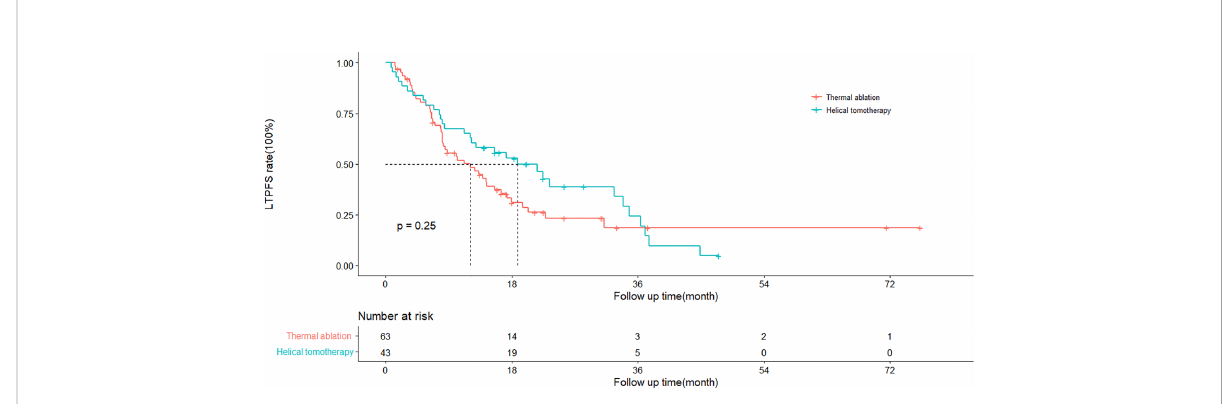
FIGURE 2 Kaplan – Meier curves of local tumor progression-free survival (LTPFS) in patients with pulmonary metastases from hepatocellular carcinoma who underwent thermal ablation or helical tomotherapy (thermal ablation group: n = 63, median LTPFS = 22.5 months; helical tomotherapy group: n = 43, median LTPFS = not reached; P =